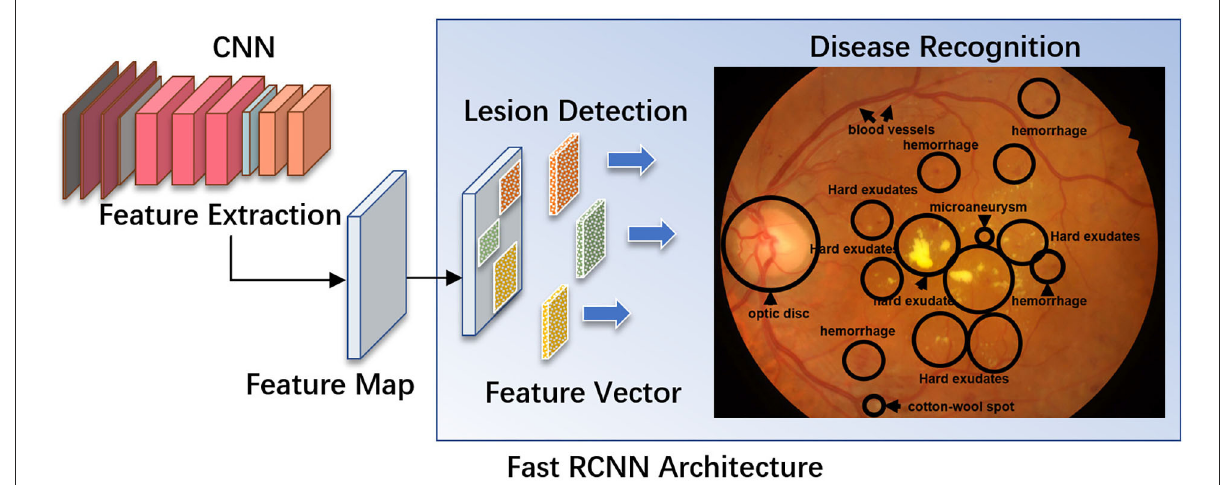
FIGURE1 A diagram illustrating a fast R-CNN algorithm for automatic lesion detection and disease recognition from fundus images. The input fundus image will be fed into the CNN network to get the corresponding feature map. The derived feature map will be used to estimate region proposals (candidate lesion regions in squared boxes), which will then be classified and predicted as different disease categories. FC, fully connected layers; DM, diabetes mellitus; DR, diabetic retinopathy; R-CNN, region-based convolutional neural network; ROI, region of